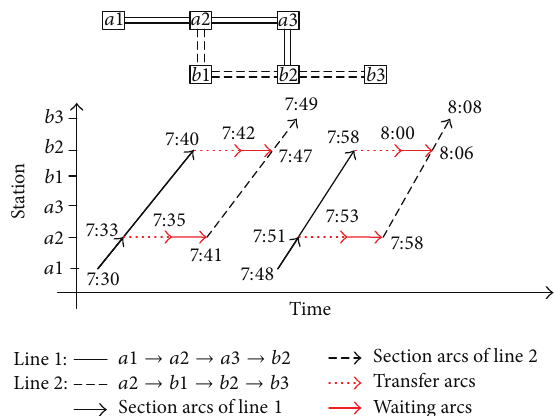
Figure 1: A SE network based on the route network of one O-D pair in time